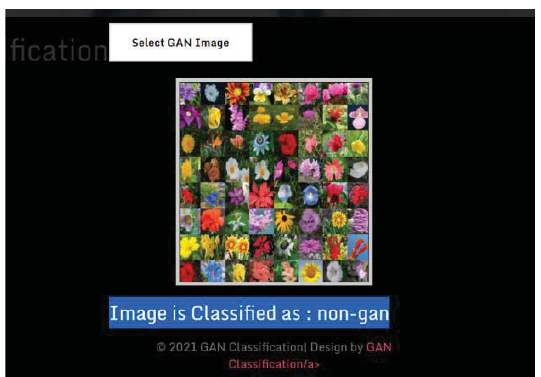
Fig. 9. 8x8 Real image